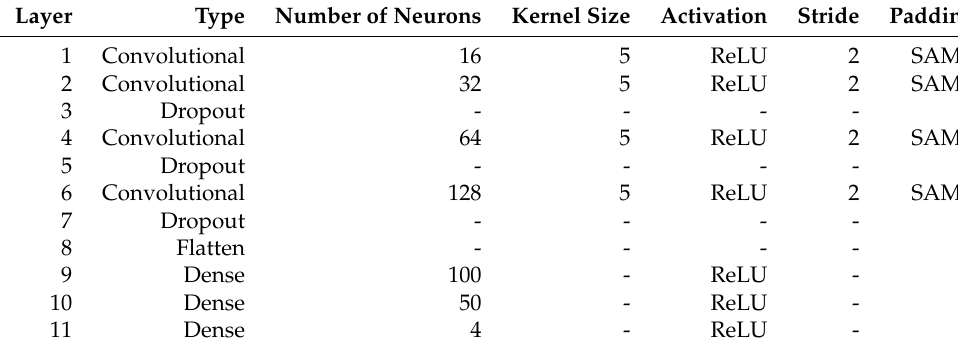
Table 4. Topology for the CNN